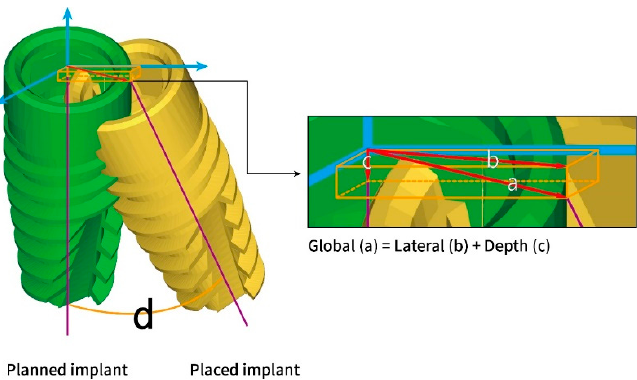
Figure 6. Definitions of the deviations between planned and placed implants at the implant platform: ( a ) global deviation, ( b ) lateral deviation, ( c ) depth deviation, and ( d ) angular deviation. The deviations at the implant apex were defined and measured by the same coordinate system (blue arrows).